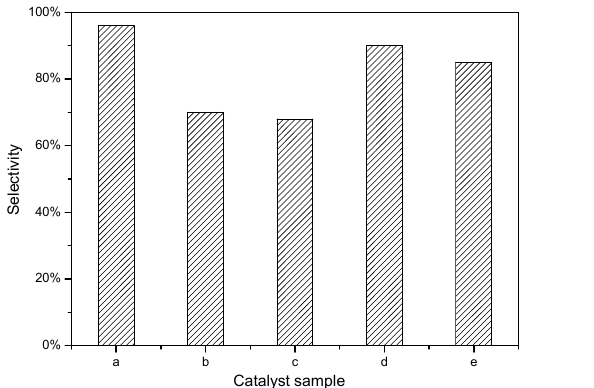
Figure 10. Catalytic activity of all samples.